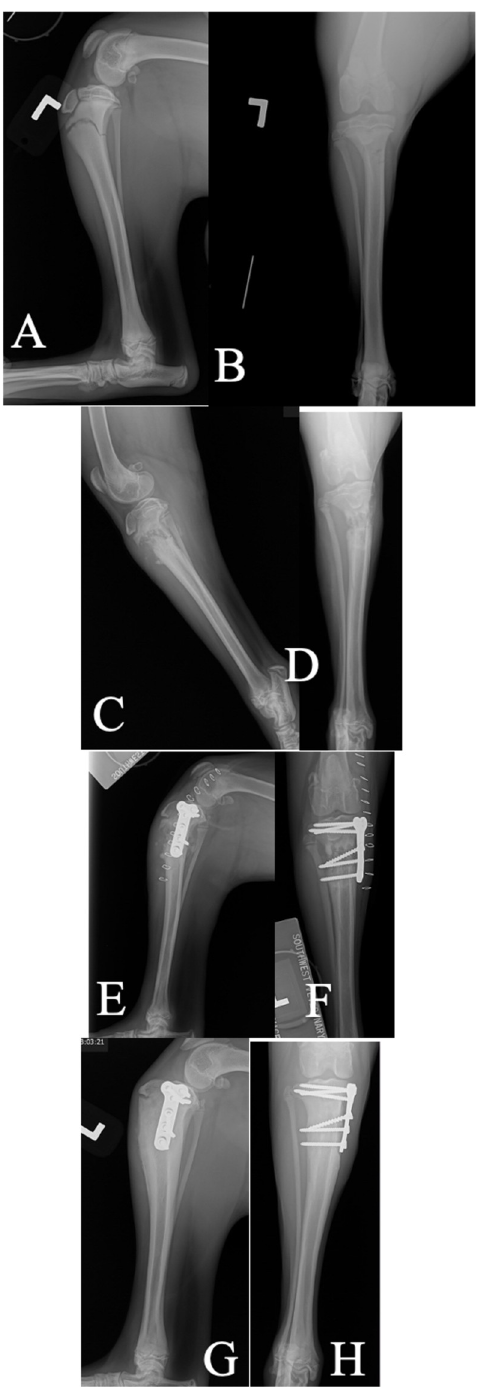
Fig 11. Inadvertent place of the most proximal screw through the proximal tibial physis and into stifle joint after the case was first medically managed with a splint bandage (Case 17). A and B: Mediolateral and craniocaudal views performed 1 day after the initial injury: C and D: Mediolateral and craniocaudal views performed 3 weeks post splint placement. There was concern for collapsing of the lateral tibial cortex resulting in increased tibial angulation. The patient was still grade 4/4 lame on exam, so surgical stabilization was elected. E and F: Mediolateral and craniocaudal views immediately postoperatively showing screw placement into the joint. G and H: Mediolateral and craniocaudal views performed 6 weeks postoperatively with screw placement still within the joint, but patient was not lame or painful on exam.